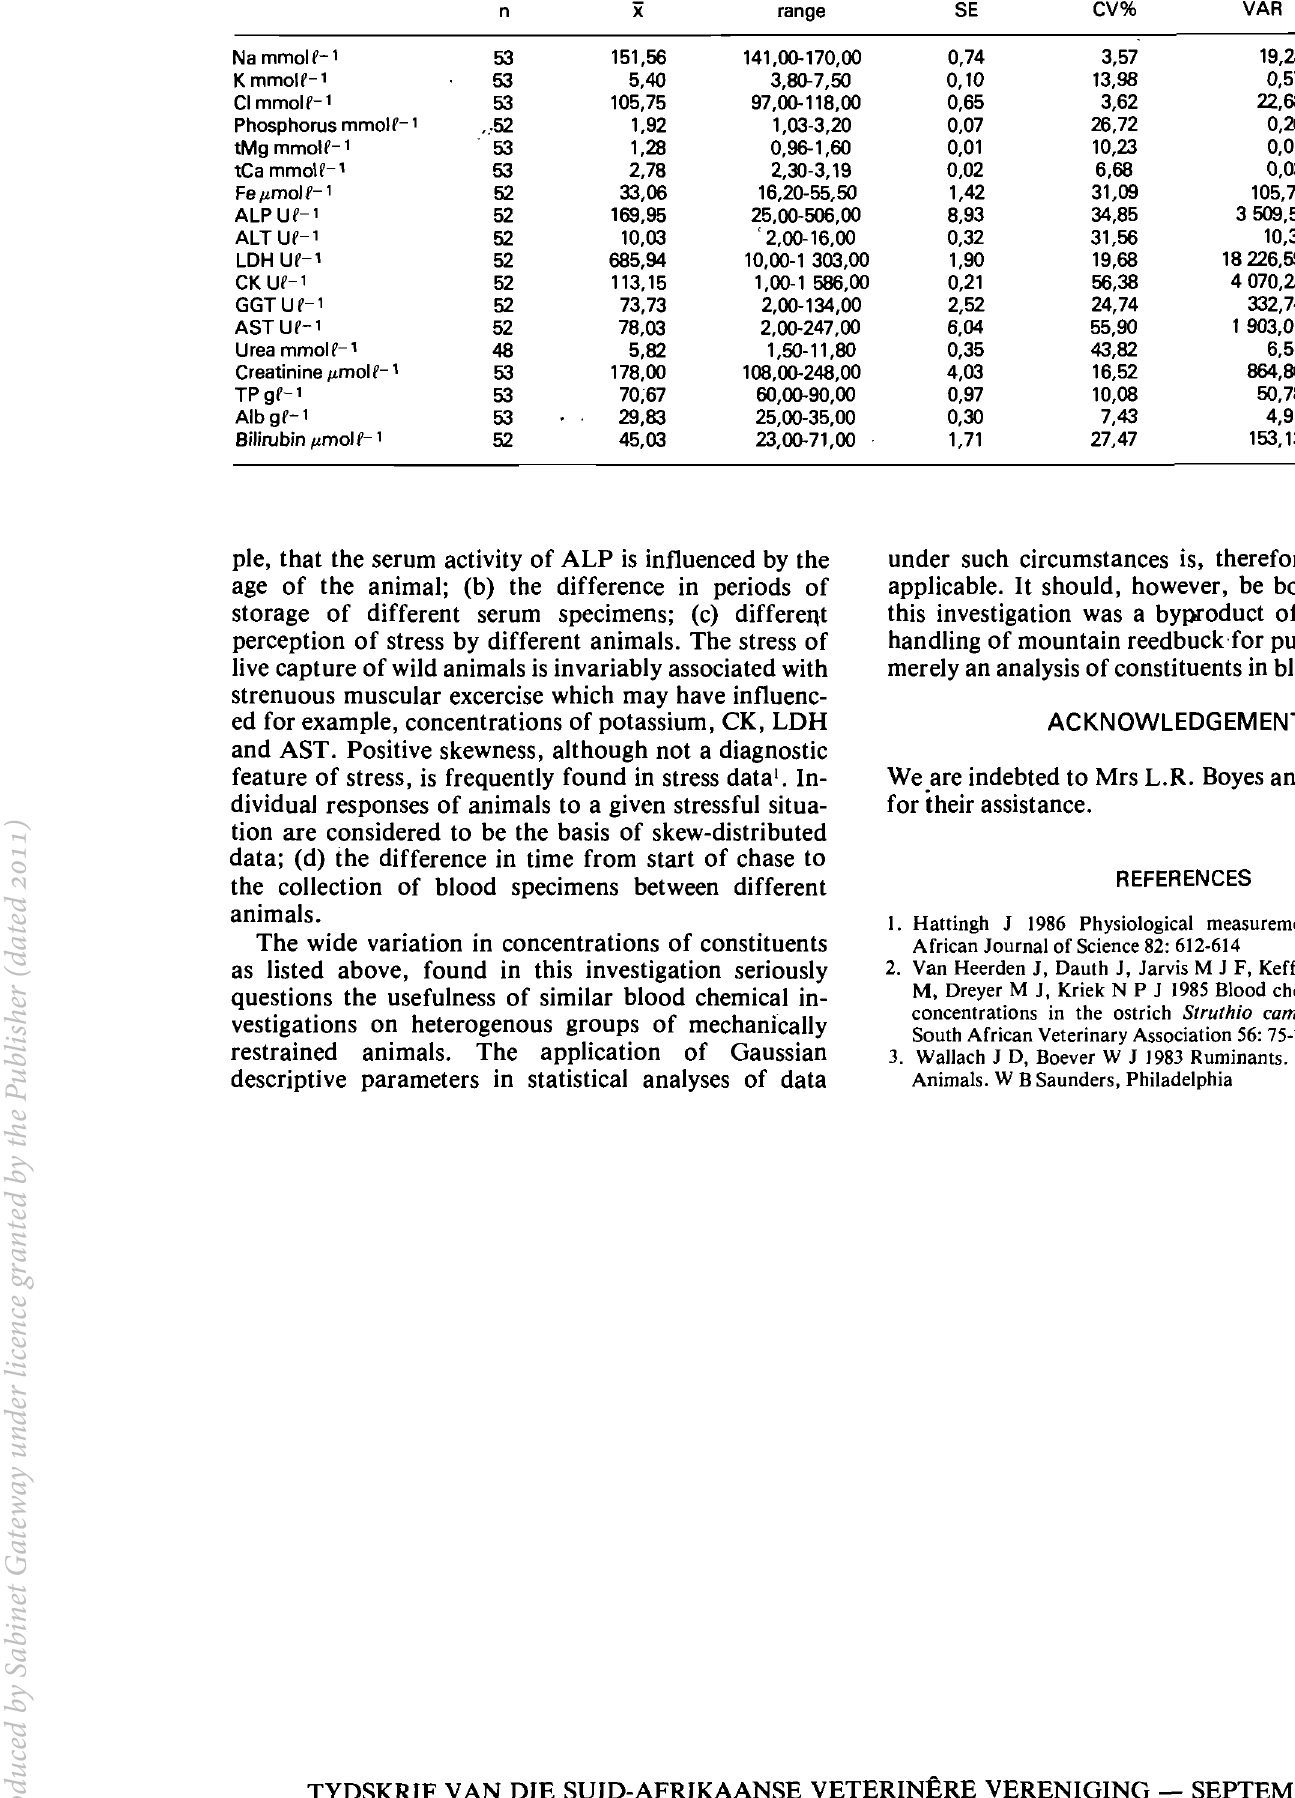
Table 1: The mean (x), standard error of the mean (SE), coefficient of variation % (CV%), variance (Var) and standard deviation (SD) for the different constituents evaluated in serum of mountain reedbuck. n x range Na